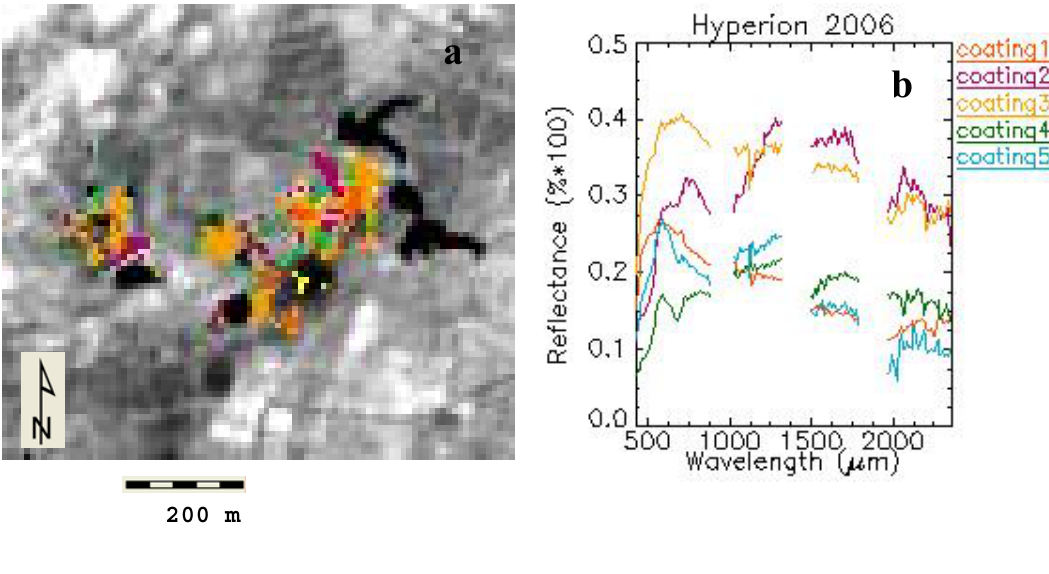
Figure 7. (a) Geological map from Hyperion data corrected with the Empirical Line method on pyrite weathering products over the mine dumps. The legend follows the trends shown on the map built from Hymap 2009 data (Figure 5). (b) Spectra from Hyperion data from the geological units represented on the